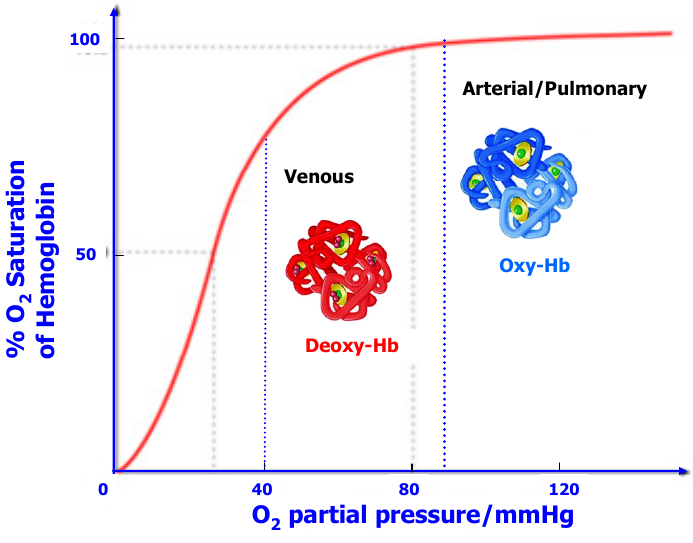
Figure 11. In a bio-system, the O -association parameter of hemoglobin (Hb) varies with 2 the external O -partial pressure by adopting two different conformations, Oxy-Hb with 2 high affinity and deoxy-Hb with low affinity towards O . Thus, O tends to be dissolved in 2 2 blood where its concentration is high while released where its concentration is low. The overall result is an accelerated transport of O within the system, which is impossible with 2 -chelating agent that has a constant association parameter, like what Li ion has a simple O 2 in conventional